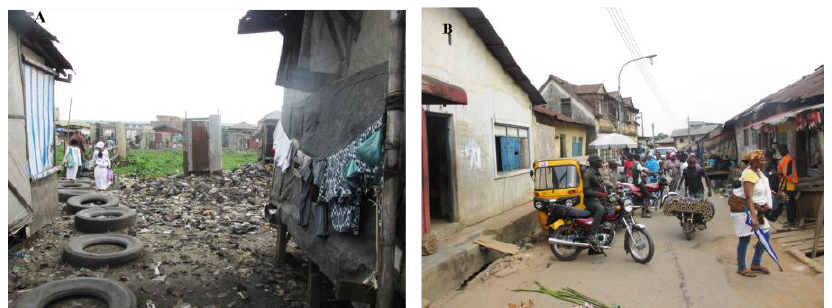
Figure 3. Squatter ( A ) and slum ( B ) communities in Lagos (author’s photo, 2017).